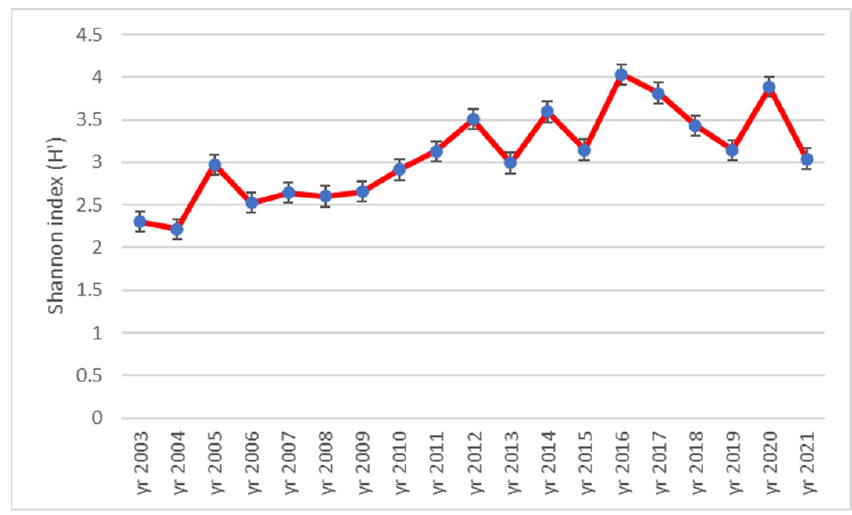
Figure 5. Dynamics of Shannon index (H’) during 2003–2021 time interval in ex-arable grassland from Gr ă dinari (standard error displayed).